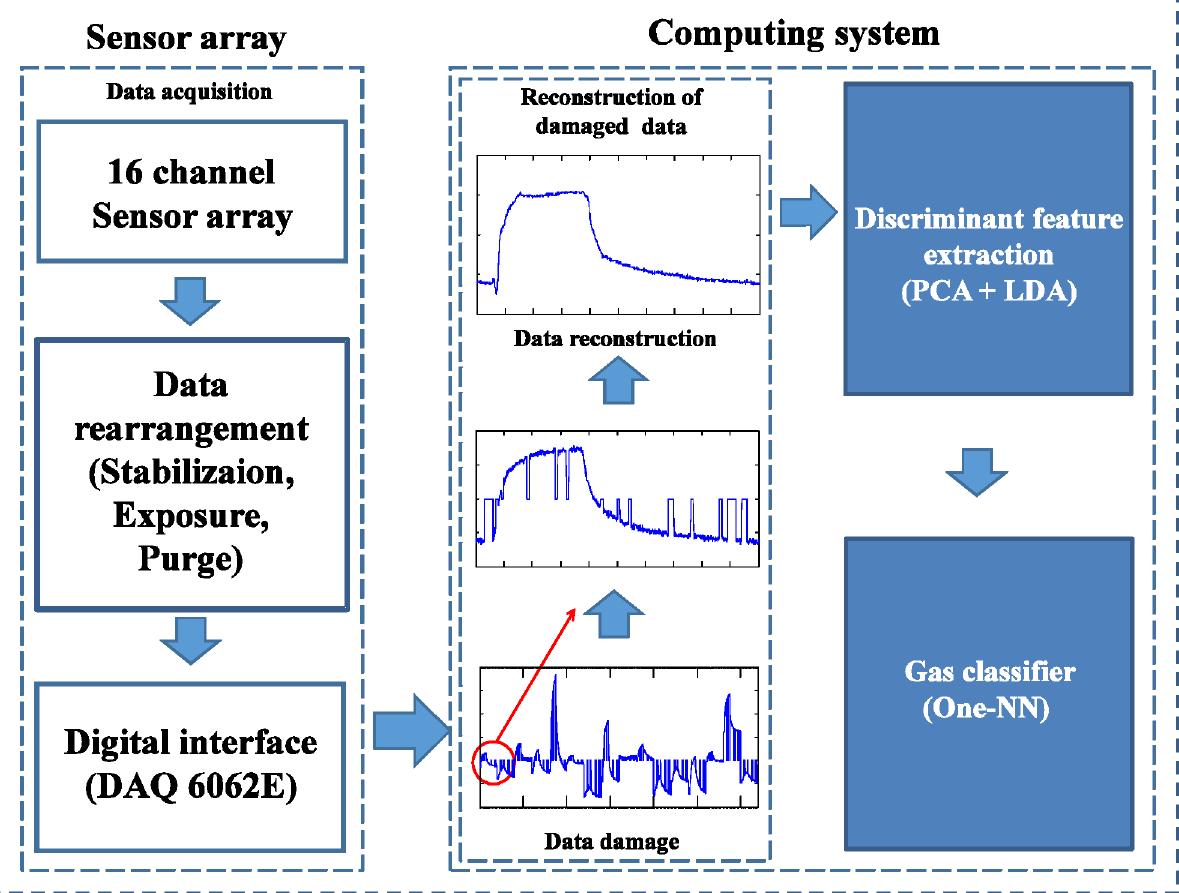
Fig 5. Schematic diagram of our electronic nose system. The gas data sample is stored as a vector through a digital interface. Then, the computing system classifies the types of gas through the data reconstruction and feature extraction steps.